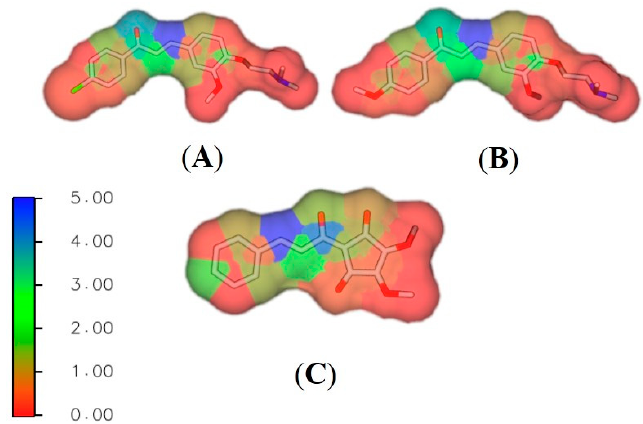
Figure 6. Atomic philicity index values ( ω + k ) projected on molecular surfaces for compounds 4a ( A ); 4d ( B ) and linderone ( C ).